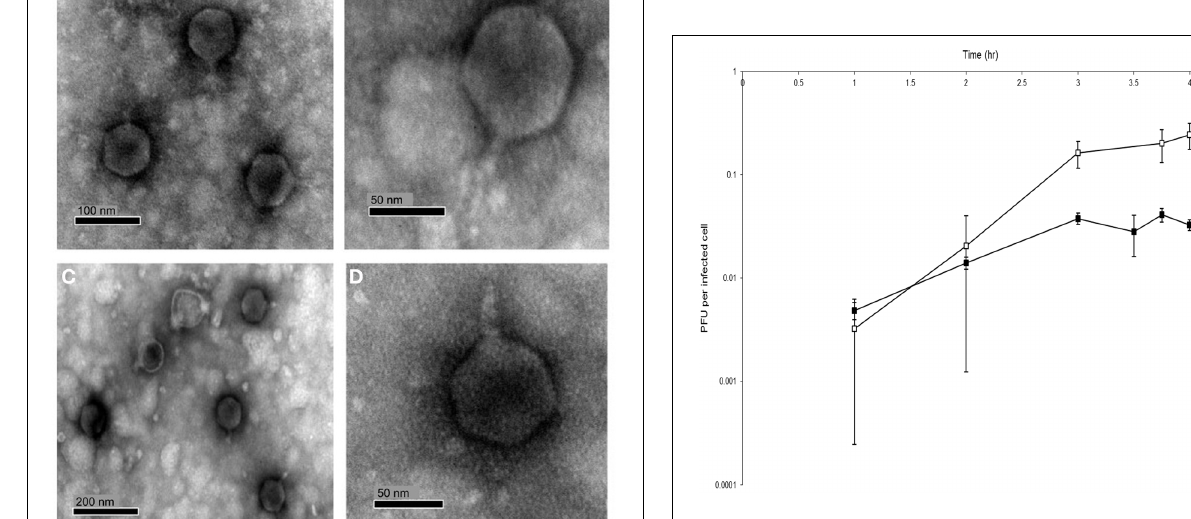
FIGURE 2 | Modified one-step growth cure for phages RLP1 and RPP1. HostcellswereinfectedwithaMOIof0.001.OnestepgrowthcurveofRLP1 on Rsv. 217 ( (cid:2) ) and RPP1 on Rsv. nubinhibens ( (cid:3) ). The number of phage increases over time indicating infection has occurred. There is a marked increase in phage between 2 and 3h which suggests a burst event has occurred during this period. Each growth curve was performed in